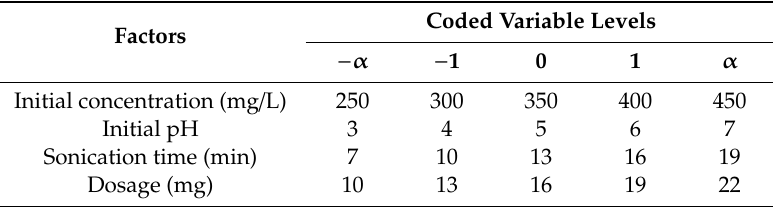
Table 1. Four factor, five level central composite